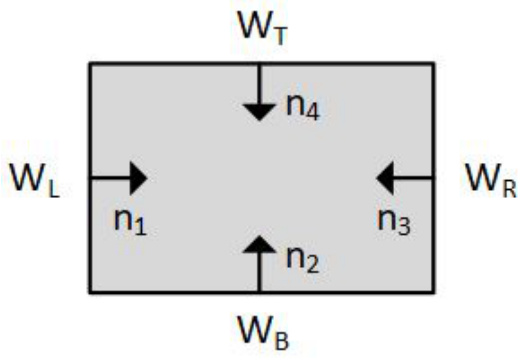
Figure 5. Inward normals of a rectangular clipping window.